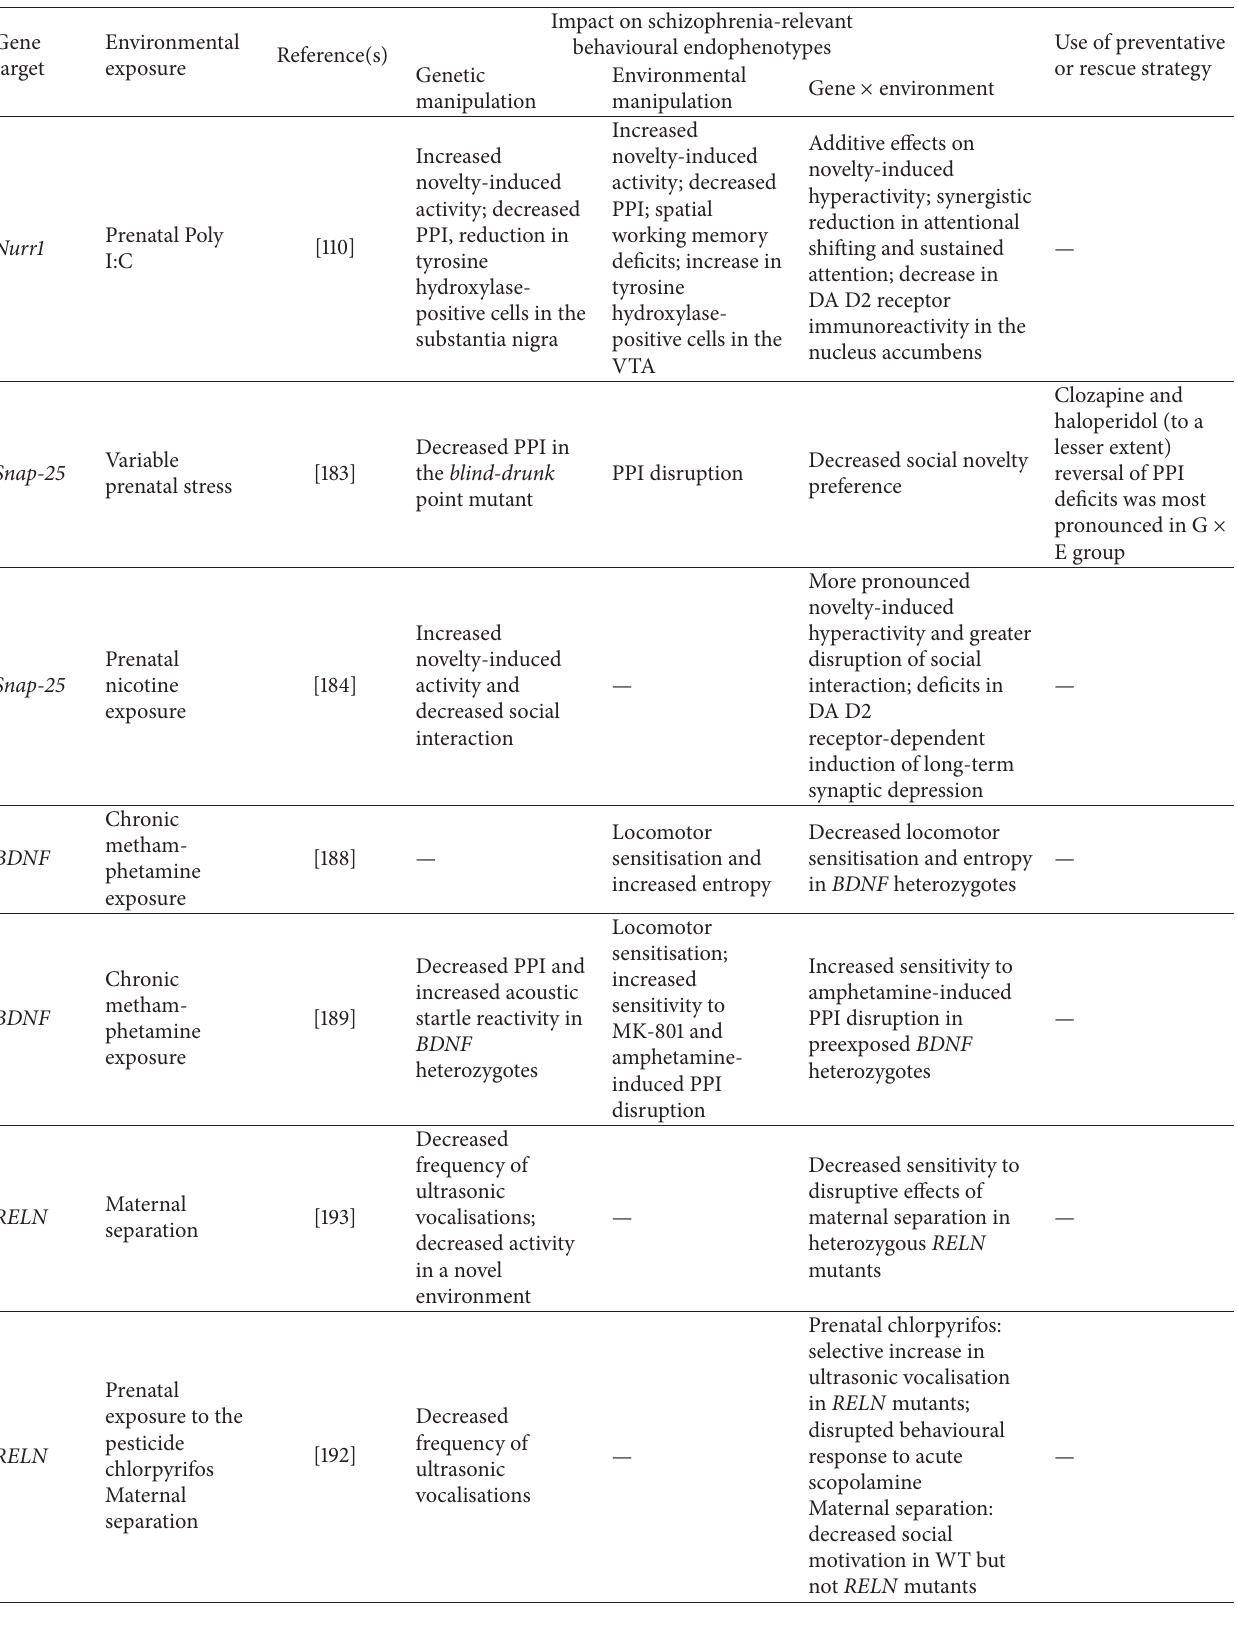
Table 2: Summary of evidence for gene, environment, and gene × environment effects in mutant models for selected genes associated with